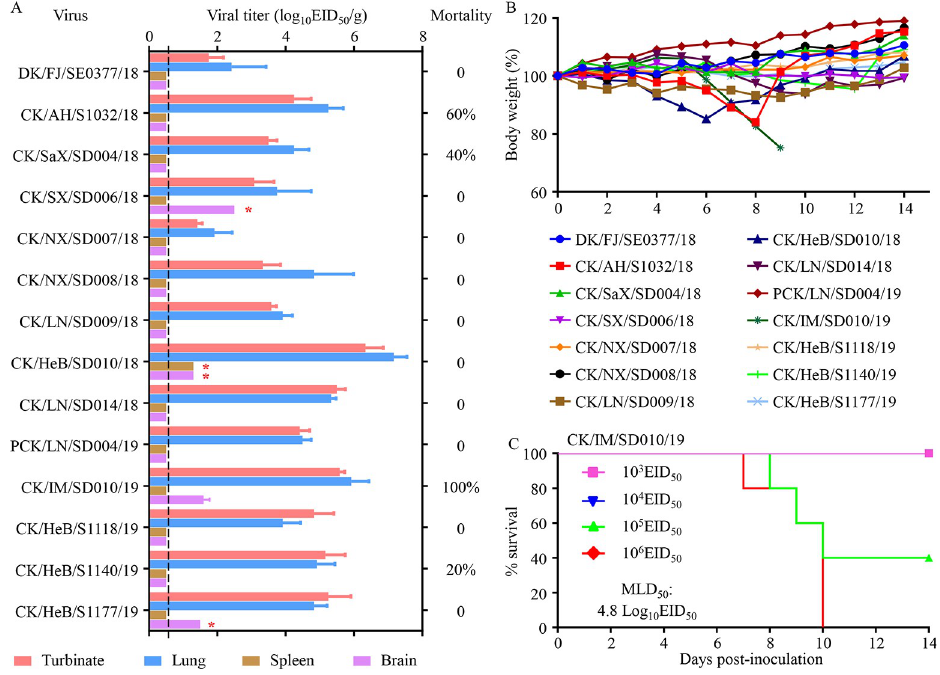
Fig 2. Replication and virulence of H7N9 viruses in mice. (A) Viral titers in organs of mice after inoculation with 10 6 EID 50 of different viruses. Three mice from each group were killed on Day 3 p.i., and virus titers were determined in eggs. Color bars show the mean, and the error bars represent standard deviations. The values labeled with a red star indicate that the virus was only detected in the organ of one mouse. The dashed lines indicate the lower limit of virus detection. (B) Changes in body weight in the groups of five mice after inoculation with 10 6 EID 50 of different viruses. (C) Mouse-lethal doses of the CK/IM/SD010/19